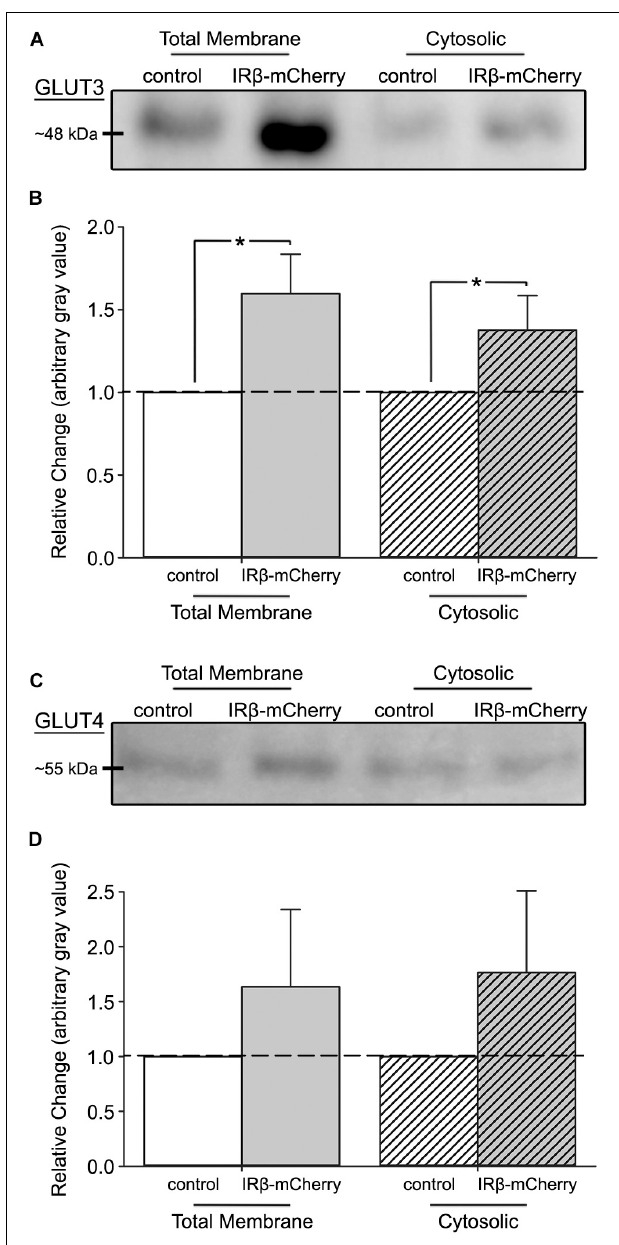
FIGURE 3 | Western immunoblots of fractionated hippocampal cultures with or without expression of IR β . (A) Representative Western immunoblots of subcellular fractions derived from mixed, primary hippocampal cultures (total membrane fraction, left; cytosolic fraction, right) probed for GLUT3. (B) Quantification of the relative change in GLUT3 expression between total membrane and cytosolic fractions ( n = 4 experiments across 5 dams, 8–16 dishes per group). A significant overall effect of virus was detected (2-way ANOVA; F ( 1 , 12 ) = 9.36, p = 0.010). (C) Representative Western immunoblots of subcellular fractions probed for GLUT4. (D) Quantification of the relative change in GLUT4 expression between total membrane and cytosolic fractions ( n = 4 experiments across 5 dams, 8–16 dishes per group). No effect of virus (2-way ANOVA; F ( 1 , 12 ) = 1.86, p > 0.05) on GLUT4 expression was detected between control and IR β -expressing cells. All control data represent means. All IR β data represent means ± SEM. Asterisks (*) indicates significance at p <